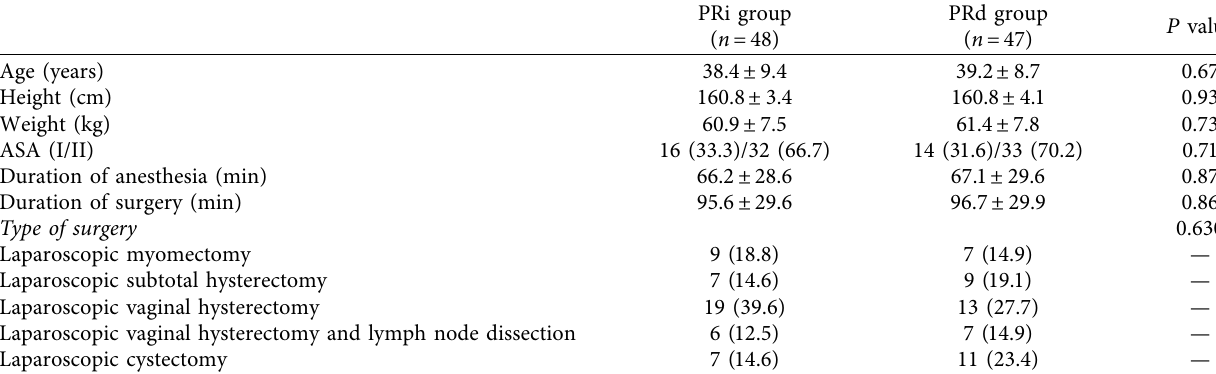
Table 1: Patient demographic data.